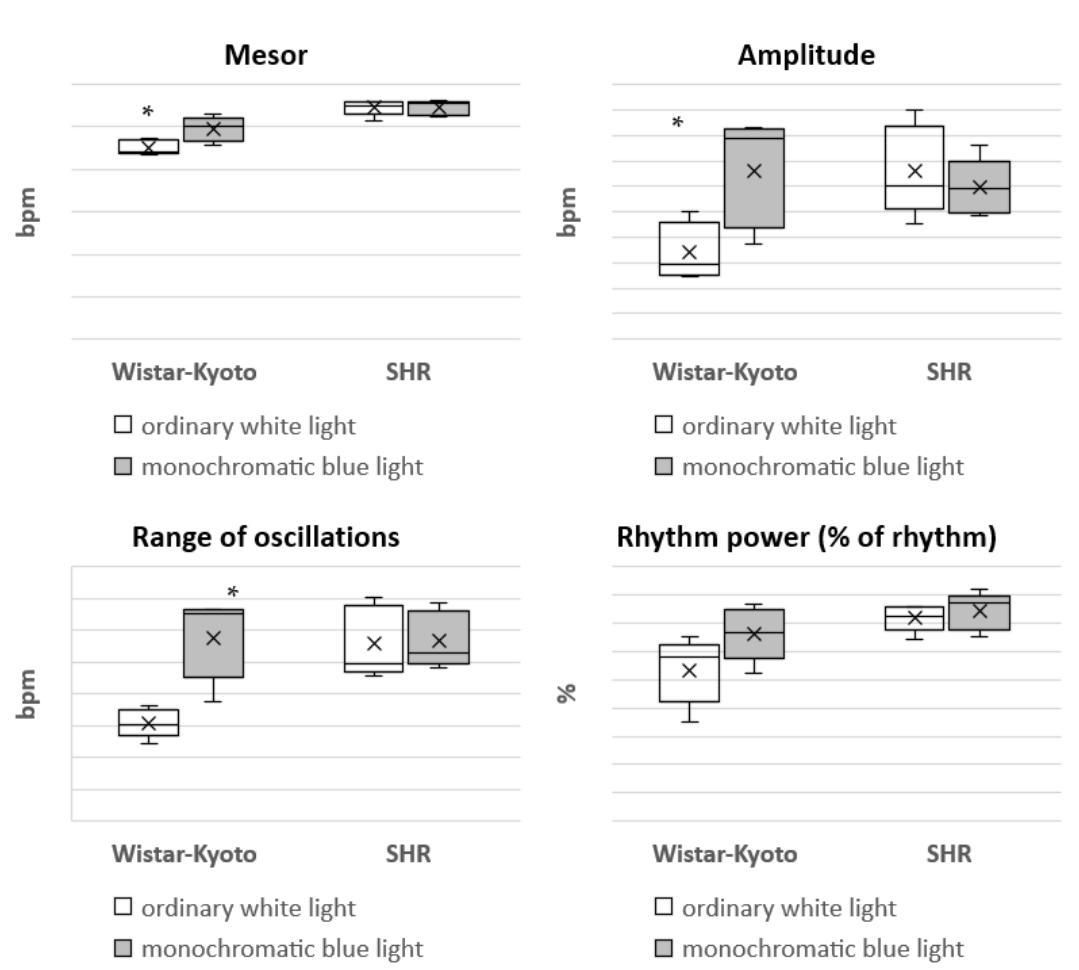
Figure 7. Rhythm power (% of rhythm) of SBP and DBP in Wistar–Kyoto and SHR rats under the standard light pattern (12 h:12 h) with ordinary white light and monochromatic blue light.